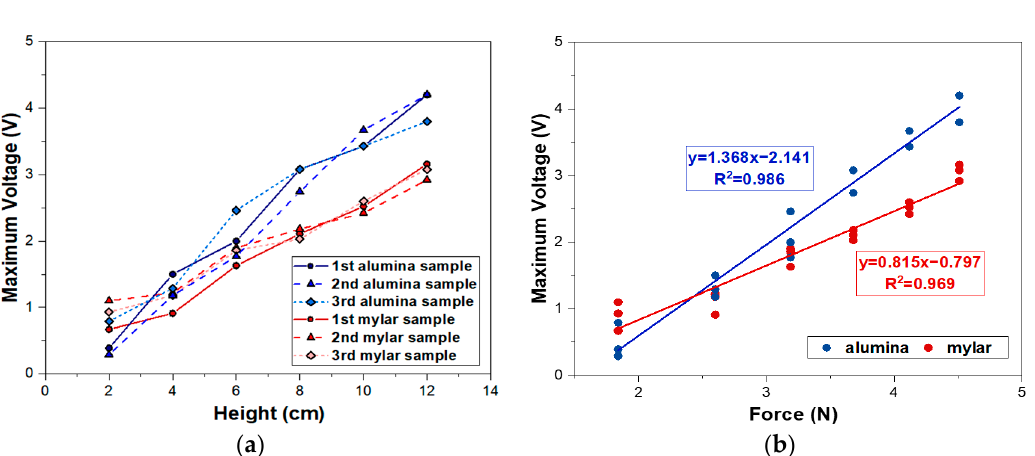
Figure 9. Comparison of impact force on the alumina and mylar substrates: ( a ) maximum voltage response as a function of height; ( b ) calibration curve of sensitivity of the